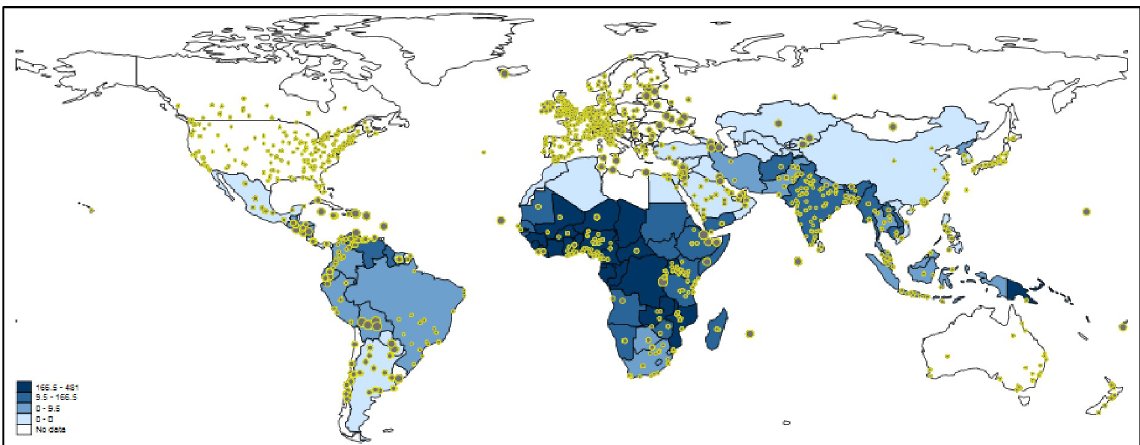
Fig 4. Tweeting on papers dealing with malaria worldwide. Each tweet is inversely weighted with the number of papers published by authors in the corresponding country: the larger the dots, the smaller the research activity. The countries are colored according to malaria incidences (per 1,000 population at risk). For various countries, e.g. Russia and Australia, no data are available. Some countries such as China or Iran block internet access to Twitter or its content (see section